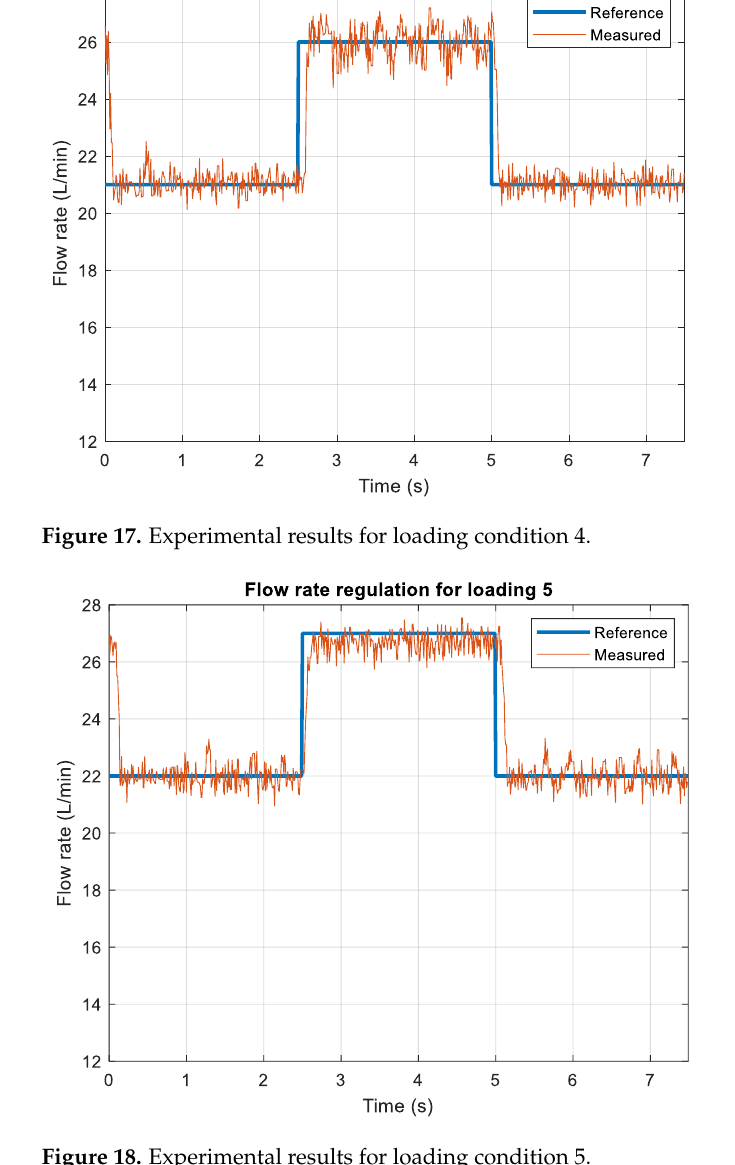
Figure 18. Experimental results for loading condition 5.